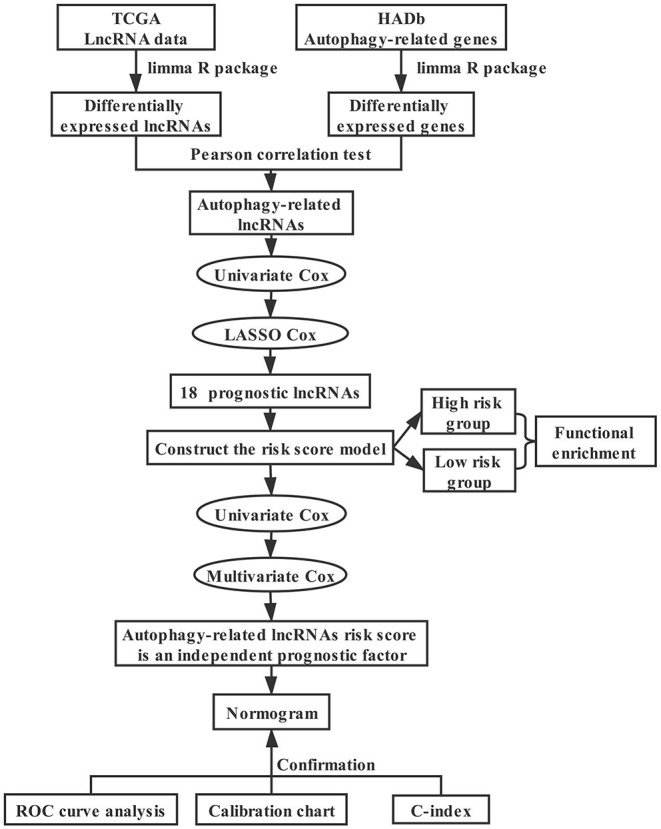
Flow chart. Flowchart for establishing and evaluating the prognostic model.